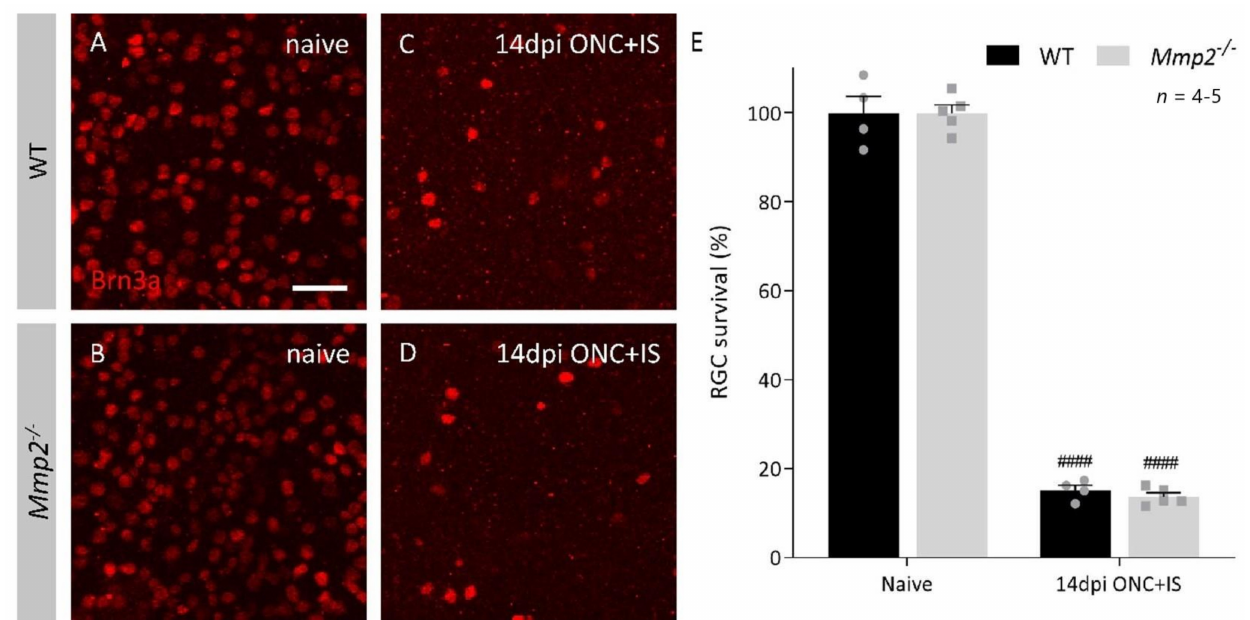
Figure 2. RGC survival in WT and Mmp2 -/- mice at 14 dpi ONC+IS in whole mount retinas. ( A – D ) Representative images of Brn3a immunostaining on retinal wholemounts in WT and Mmp2 -/- mice disclosed around 80% loss of Brn3a + RGCs at 14 dpi ONC+IS as compared to naive mice. Scale bar: 50 µ m. ( E ) Quantitative analysis on wholemounts revealed no significant difference between the number of Brn3a + RGCs surviving at 14 dpi ONC+IS in the Mmp2 -/- mice (grey) compared to WT mice (black). Data are shown as mean ± SEM. Repeated measures two-way ANOVA for RGC survival followed by a Tukey’s multiple comparison test between WT and Mmp2 -/- mice and comparing naïve and 14 dpi ONC+IS per genotype, #### p < 0.0001 for comparisons with